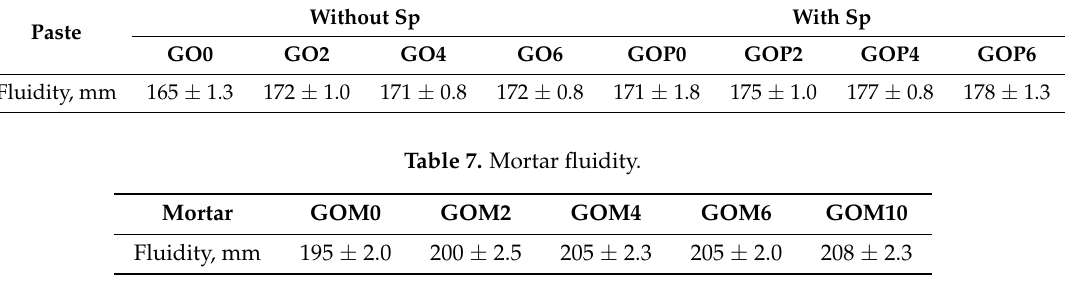
Table 6. Cement paste fluidity.